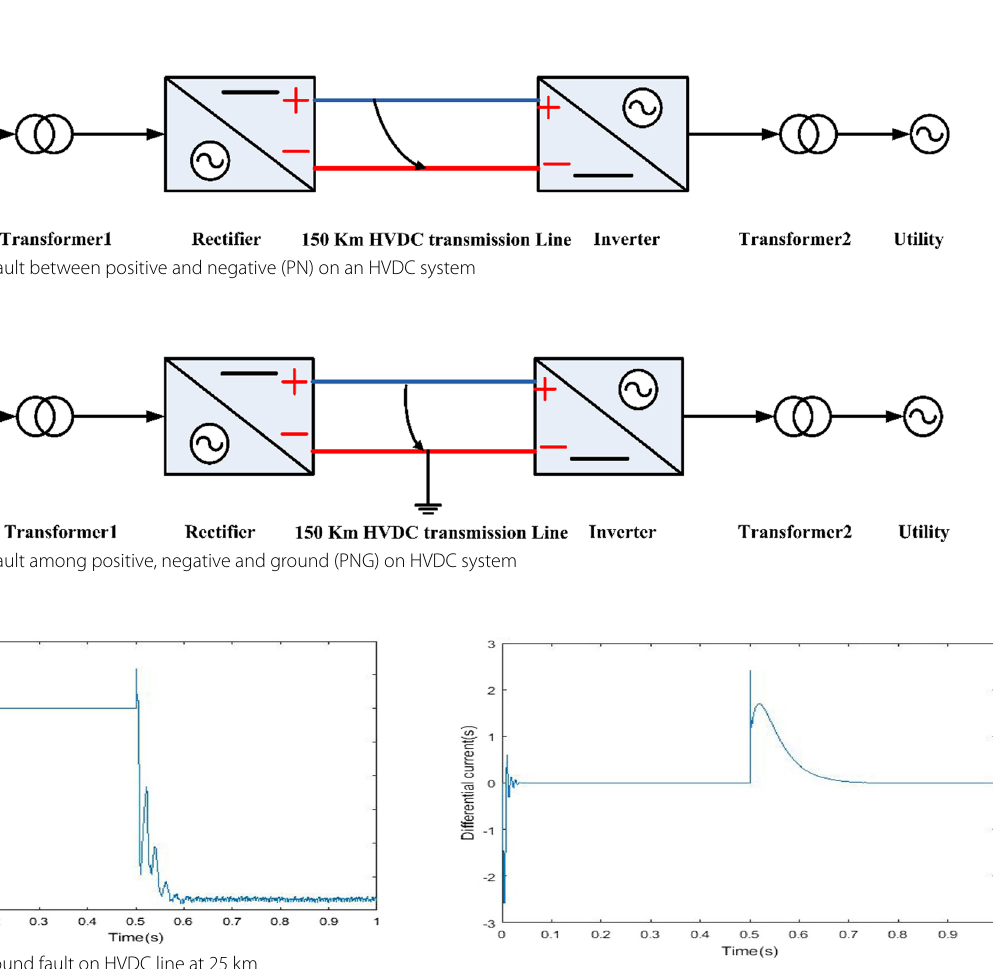
Fig. 3 Short circuit fault between negative and ground (NG) on an HVDC system